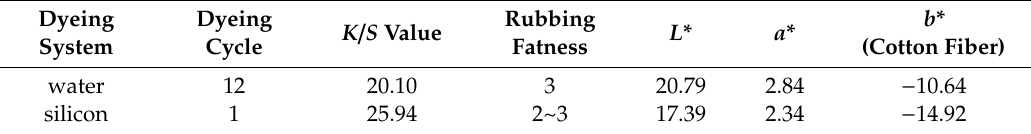
Table 1. The dyeing performance of indigo in silicon dyeing system and traditional water base.